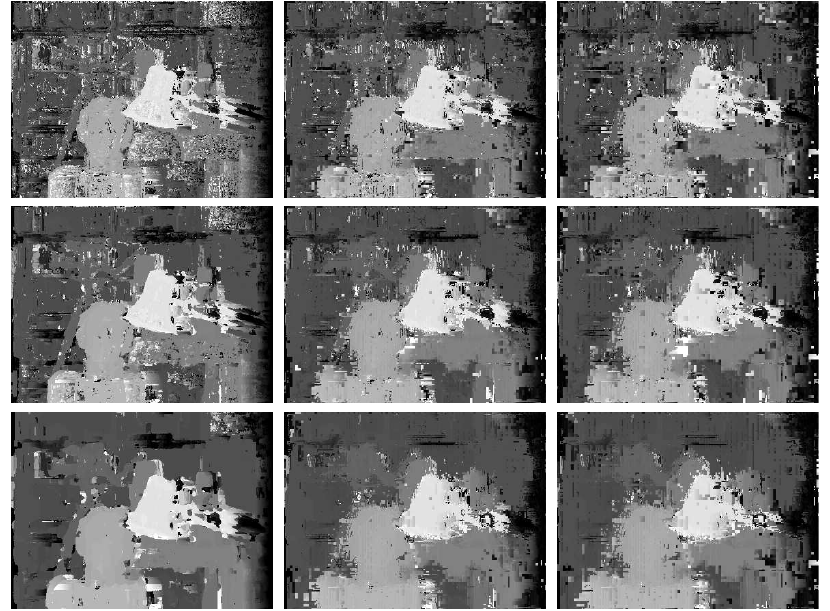
Figure 13. Visual comparison between disparity maps generated by correlation (right column) and multiresolution matching with δ ∈ { 0 . 1 , 0 . 2 } (middle and left columns, respectively), Tsukuba data set, using windows of size 3 , 5 , 9 (top, middle and bottom rows, resp.), 4 pixels search